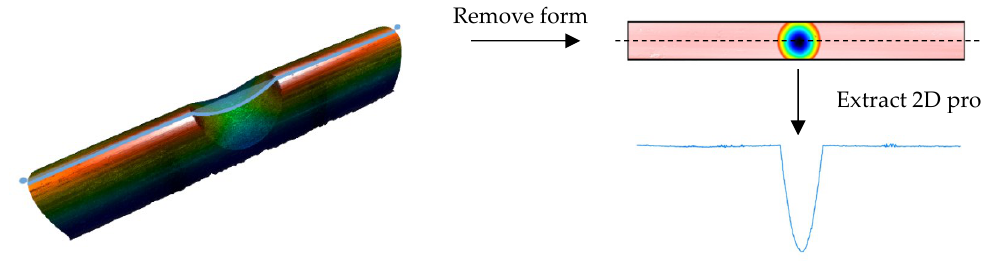
Figure 9. Image of 3D measurement of wear scar and 2D profile extraction procedure.